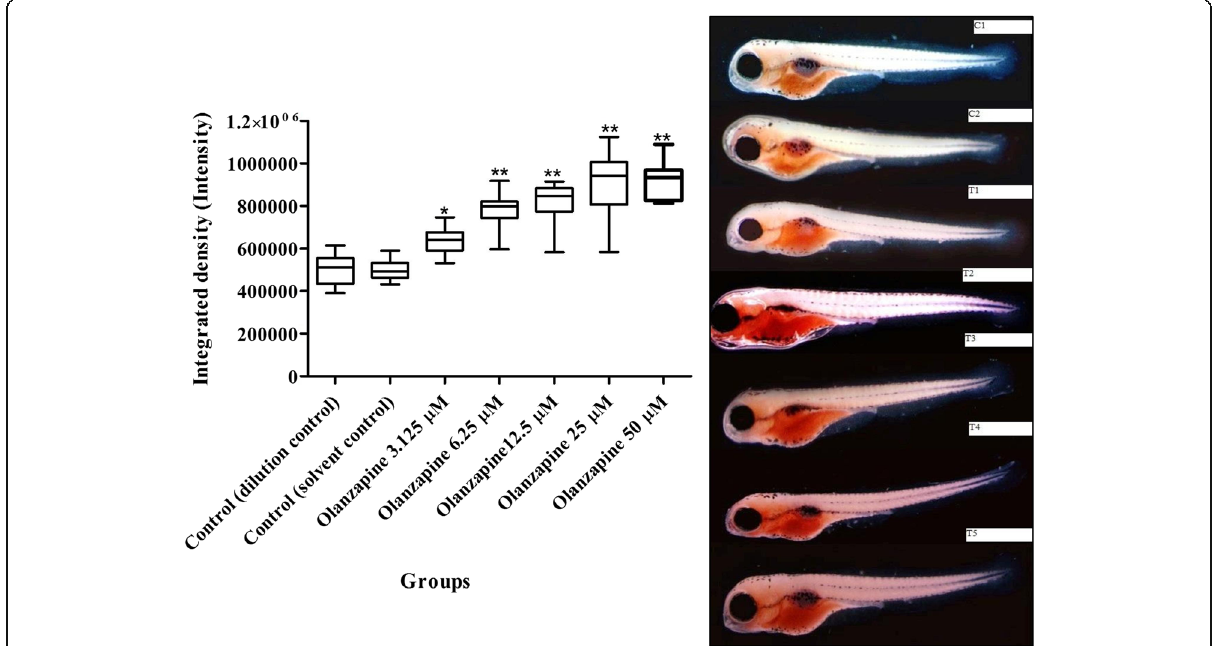
Fig. 4 Effect of olanzapine (50 μ M, 25 μ M, 12.5 μ M, 6.25, and 3.125 μ M) in lipid metabolism in zebrafish larvae. Zebrafish at 72 hpf were exposed to C1, system water; C2, 0.0001% v/v DMSO; T1, 3.125 μ M; T2, 6.25 μ M; T3, 12.5 μ M; T4, 25 μ M, and T5, 50 μ M of olanzapine. Lipids of zebrafish gut and vasculature increased with increase in the concentration of olanzapine. Scale 100 μ m. Number of larvae in each groups ( n ) = 10. All the data are expressed in mean ± SEM. * p < 0.05, ** p < 0.01 compared to solvent control